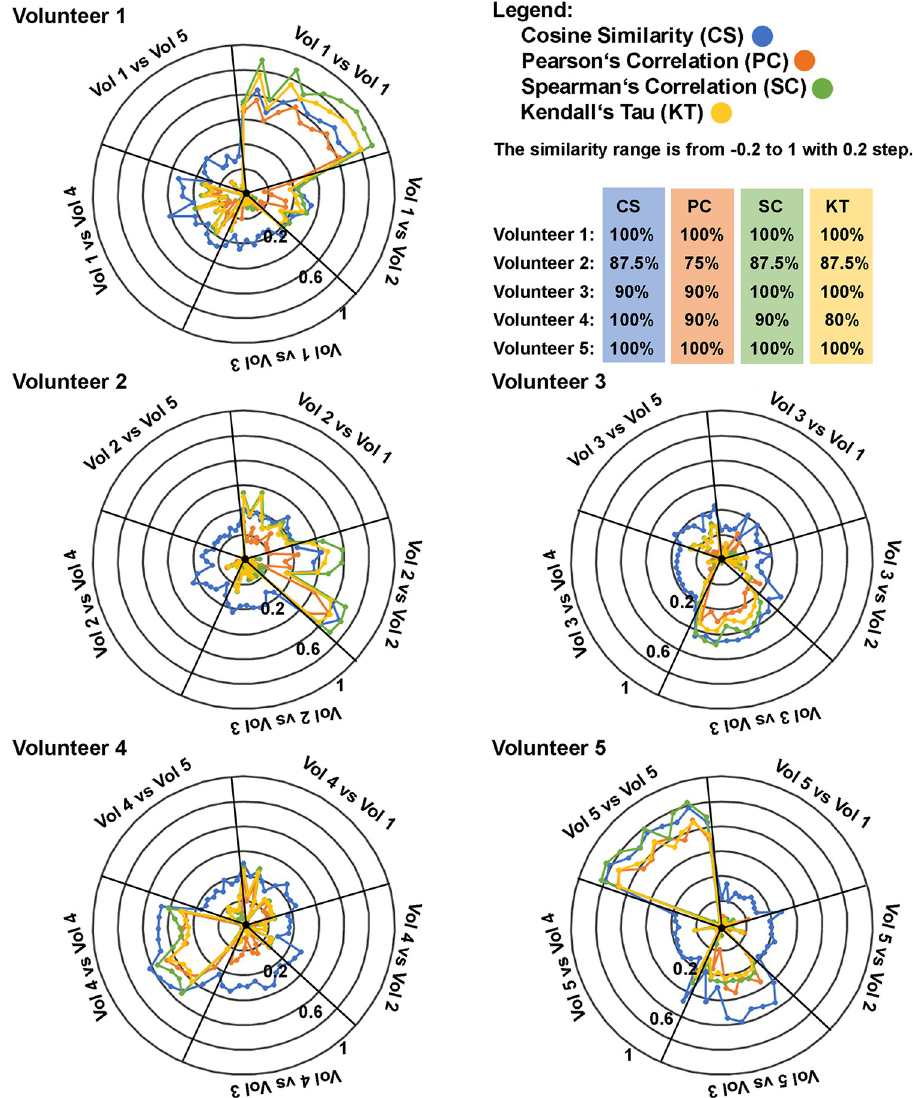
Fig 7. Graphical representations of similarity results between fired cartridge samples (10 in total) from each volunteer (Vol) against all other standard samples (47 in total). Radial black lines split the circle into five areas corresponding to the sample sets for each volunteer. The closer the color line is to the edge of the circle, the more similar the compared samples are. For each volunteer, the percentage number corresponds to the percentage of standard samples from the volunteer that reached the top correlation values when compared to their sample collected from fired cartridge. Percentage values below 100% mean that there were standard scent samples from other volunteers which were more similar to the fired cartridge sample than the standard samples from the scent